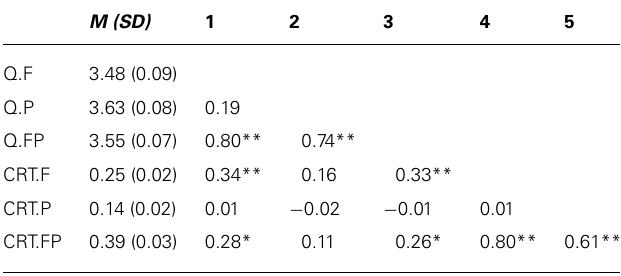
Table 4 | Means ( M ), standard deviations ( SD ), and correlations betweenTFMWQ-C and